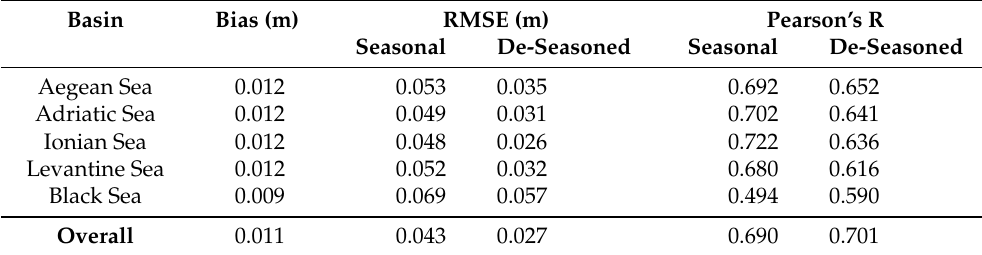
Figure 5. Sub-basin temporal-averages of zero-centered ADT for the period 1985–2014, for the EMBS simulation and AVISO satellite reanalysis, with Bias (EMBS − AVISO) and RMSE. All values are in centimeters (cm). Table 3. Metrics of ADT (zero-centered) time-series comparison between EMBS simulation and AVISO satellite reanalysis data, for each sub-basin. Correlations are statistically significant for the whole domain ( p -value <